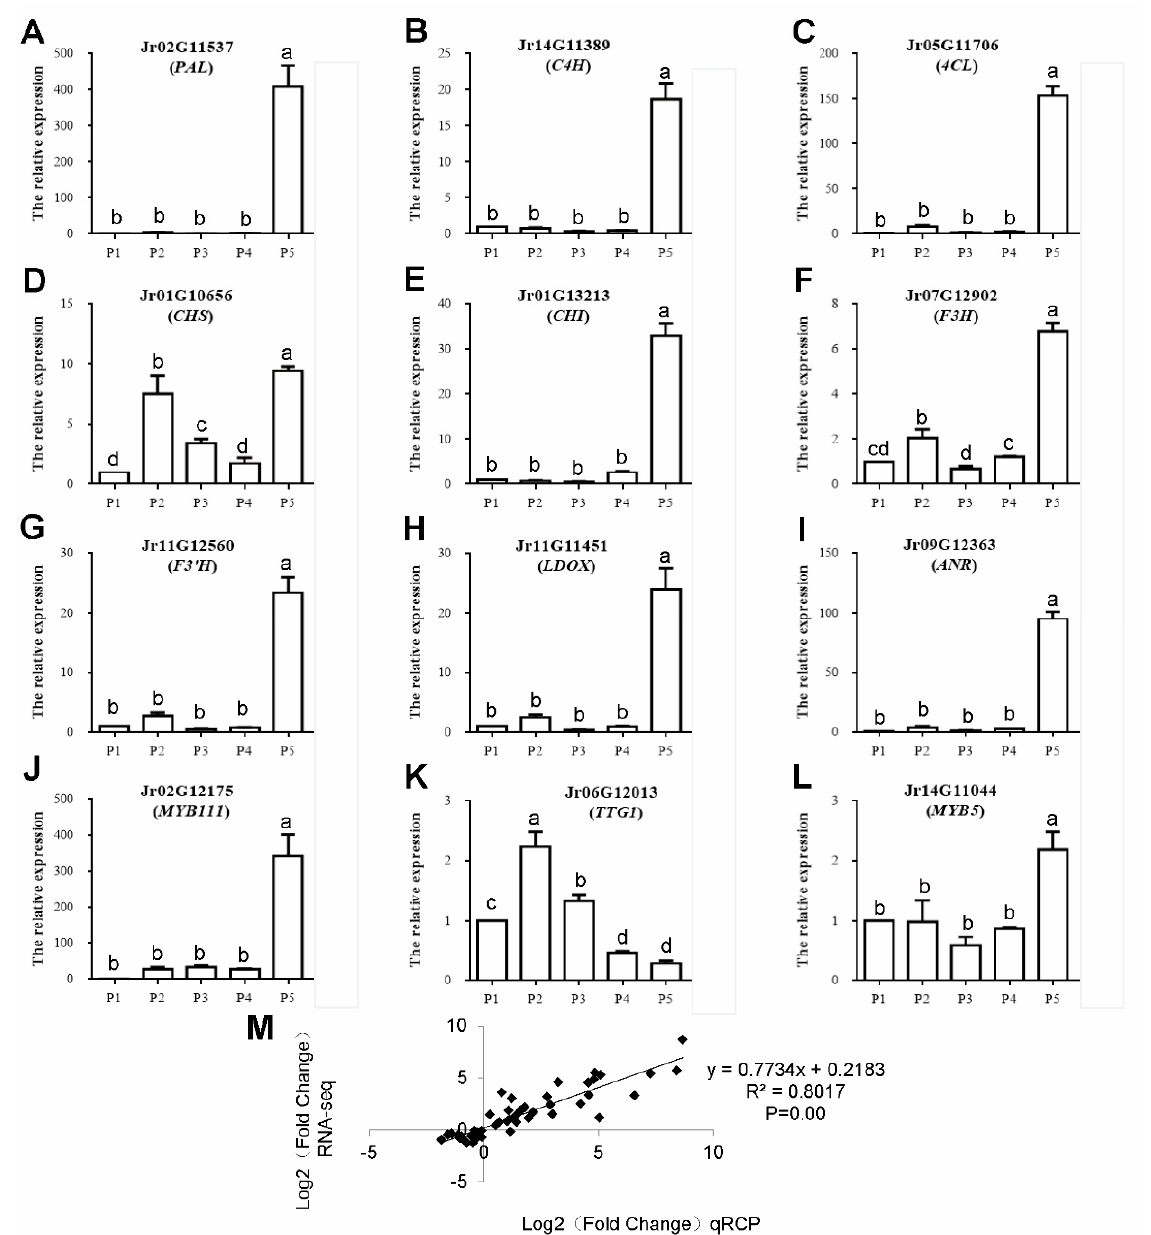
Figure 9. qPCR validation of differential expression. ( A – L ) qPCR of 12 important genes associated with polyphenol biosynthesis. Symbols represent mean values and short vertical lines indicate SE (n = 3). Same letters stand for statistically insignificance ( p > 0.05). The unit of measure on the x -axis is sample. ( M ) A comparison of the gene expression ratios obtained from RNA-seq data and